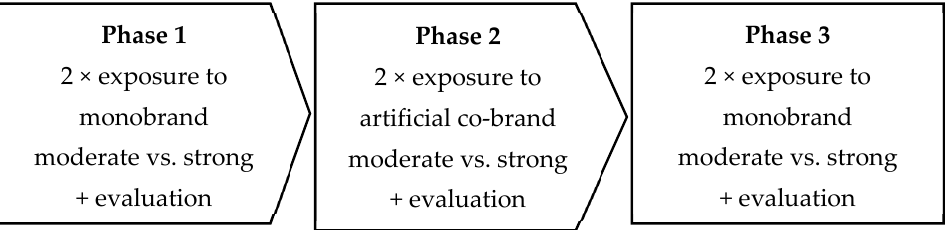
Figure 4. Experimental design of study 2.